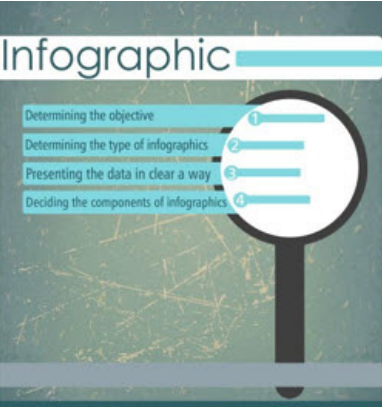
Figure 1. Preparation steps for info - graphics, Davis and Quinn